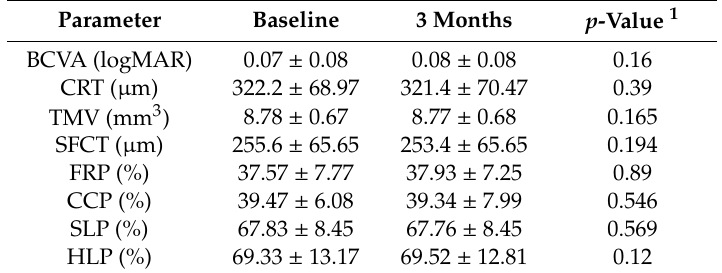
Table 4. Anatomical and functional parameters of healthy fellow eyes at baseline and 3 months follow up